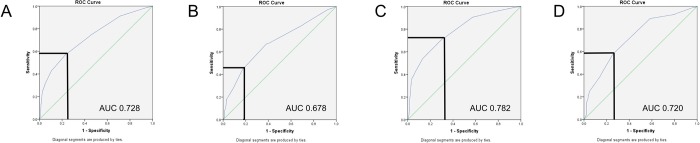
ROC curves for apical descent as a test for symptomatic prolapse.Bold lines define cutoff (C = -5). (A) women with uterus in situ, (B) women after hysterectomy. After exclusion of women with dominant prolapse in other compartments, similar results were obtained in women with uterus in situ (C) and after hysterectomy (D) (n = 2050).